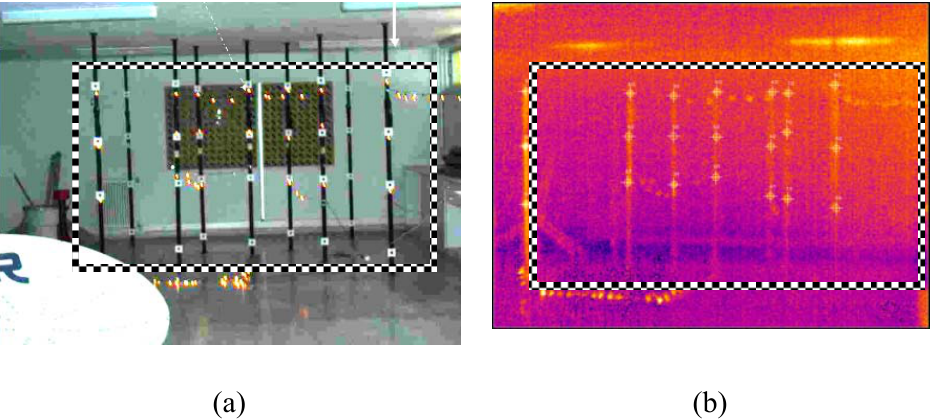
Figure 2 . (a) 3-D calibration tests deployed in the Photogrammetry Laboratory (NTUA) and (b) a sample image taken during the calibration test. The black and white box indicates the effective area of measurements.